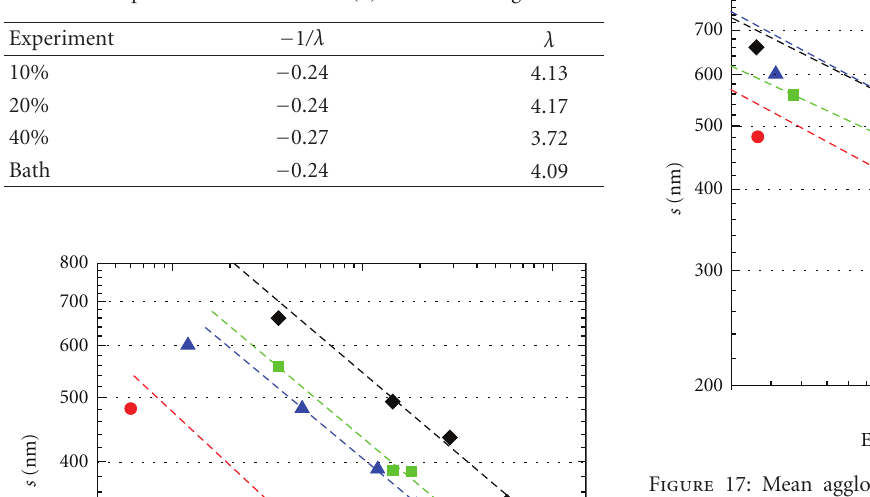
Table 1: Exponents of fitted data to (4) as shown in Figure 16.